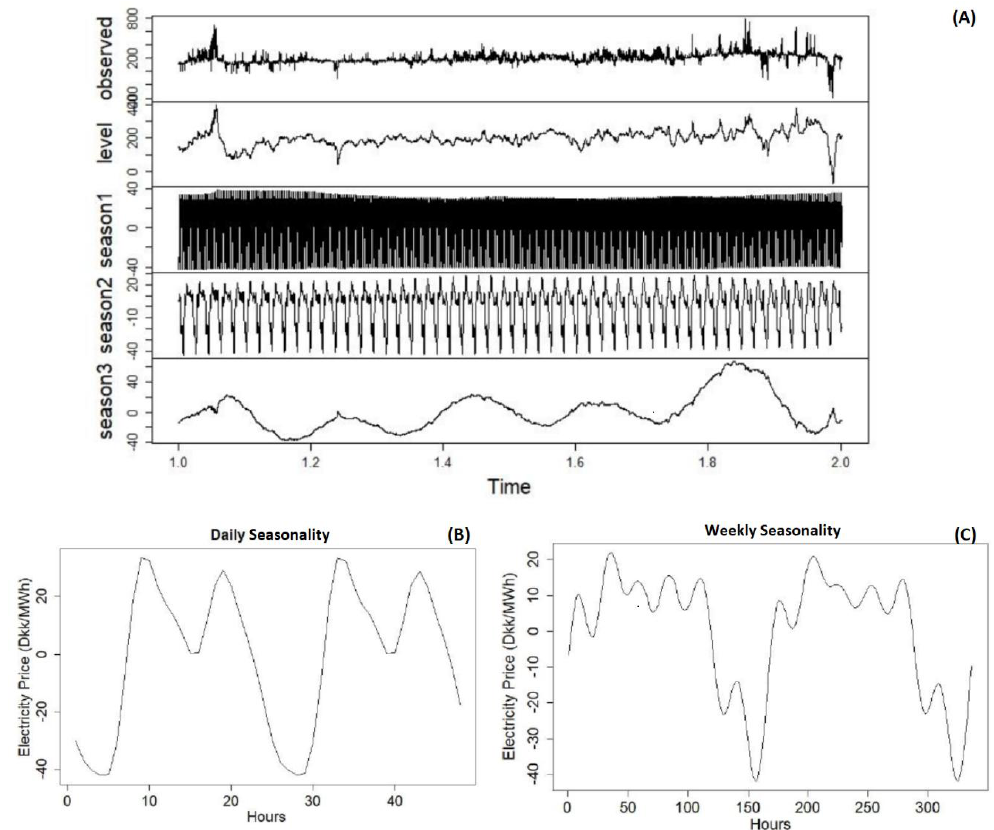
Figure 6. Decomposition by TBATS model ( A ), daily ( B ), and weekly seasonality ( C ). Energies 2019 , 12 , x FOR PEER REVIEW 12 of 32